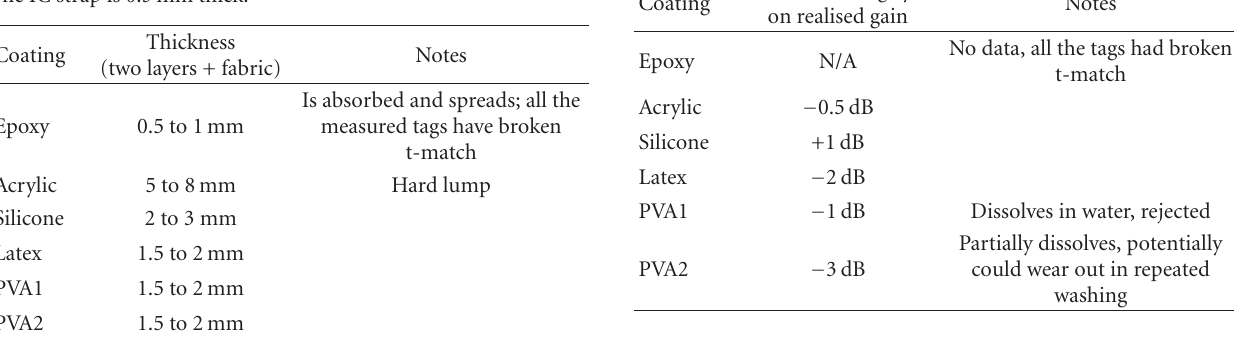
Table 3: Observations and thicknesses of the tags with a coated IC. Fabric A is approximately 0.4mm thick and Fabric B 0.8mm thick. The IC strap is 0.3mm thick.